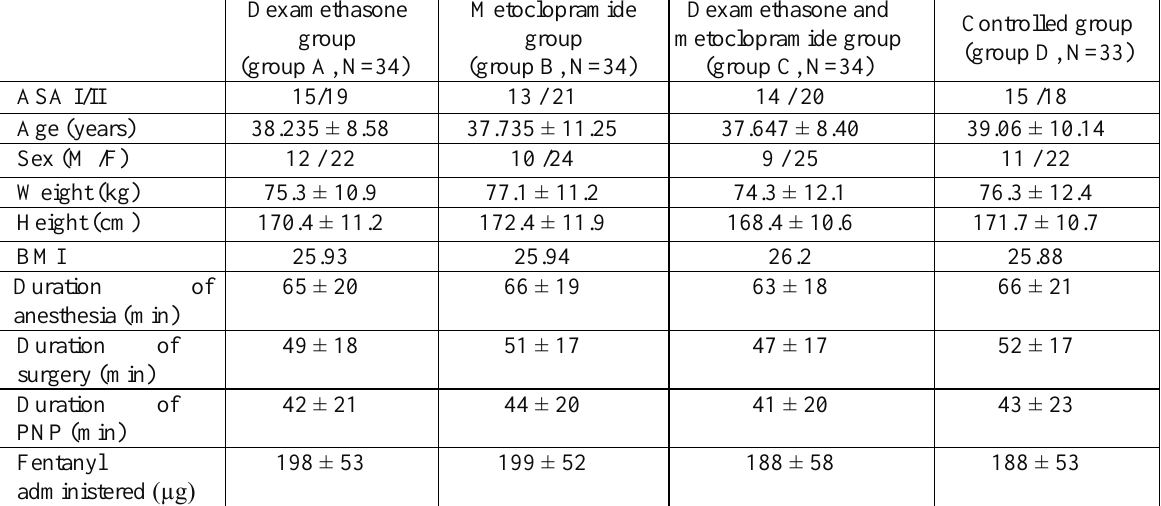
Table 1: Patients characteristics according to groups